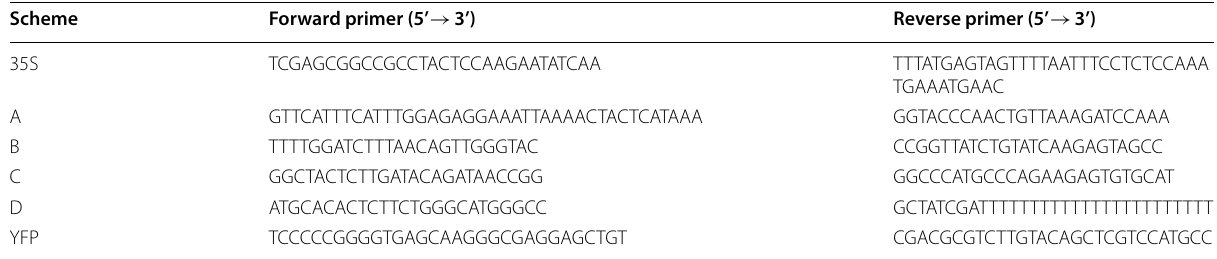
The primers were designed according to the full-length reference genome sequence of SMV-SC3. The adjacent PCR fragments overlap to each other with a 25 bp long homologous arm